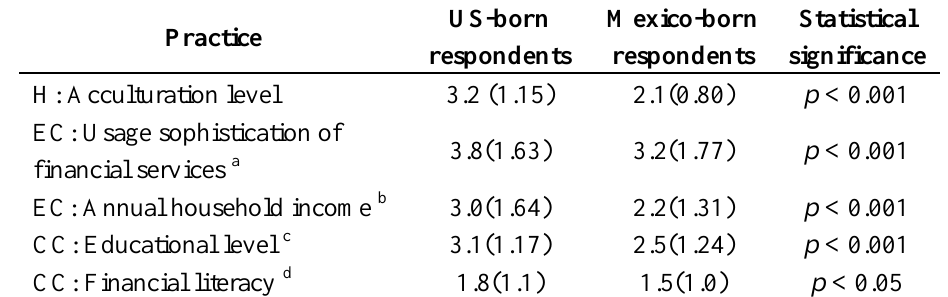
Table 2. Acculturation development differences among US-born and Mexico-born